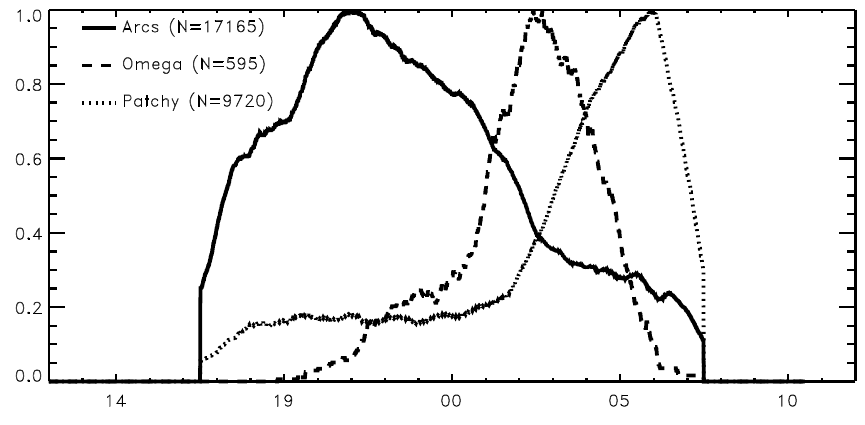
Fig. 7. Individual relative occurrences for auroral arcs, patchy auroras and Omega-bands vs. magnetic local time. The sharp cut-offs around 16:30 MLT and 07:30 MLT are due to local day- light. Note that the occurrences are in- dividually normalised and do not repre- sent relative occurrence frequency be- tween arcs, patches and